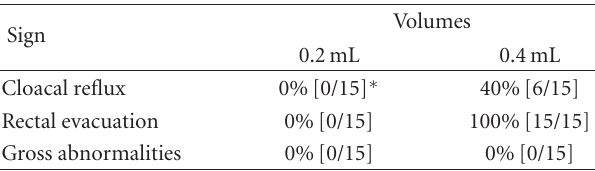
Figure 2: Di ff usion range limited to caecal tonsils as evidenced by labeling with the methylene blue dye. A: cloaca; B: rectum; C: caecal tonsils; E: ileum. Table 1: Total number of birds showing cloacal reflux, rectal evacuation, or gross abnormalities following methylene blue dye